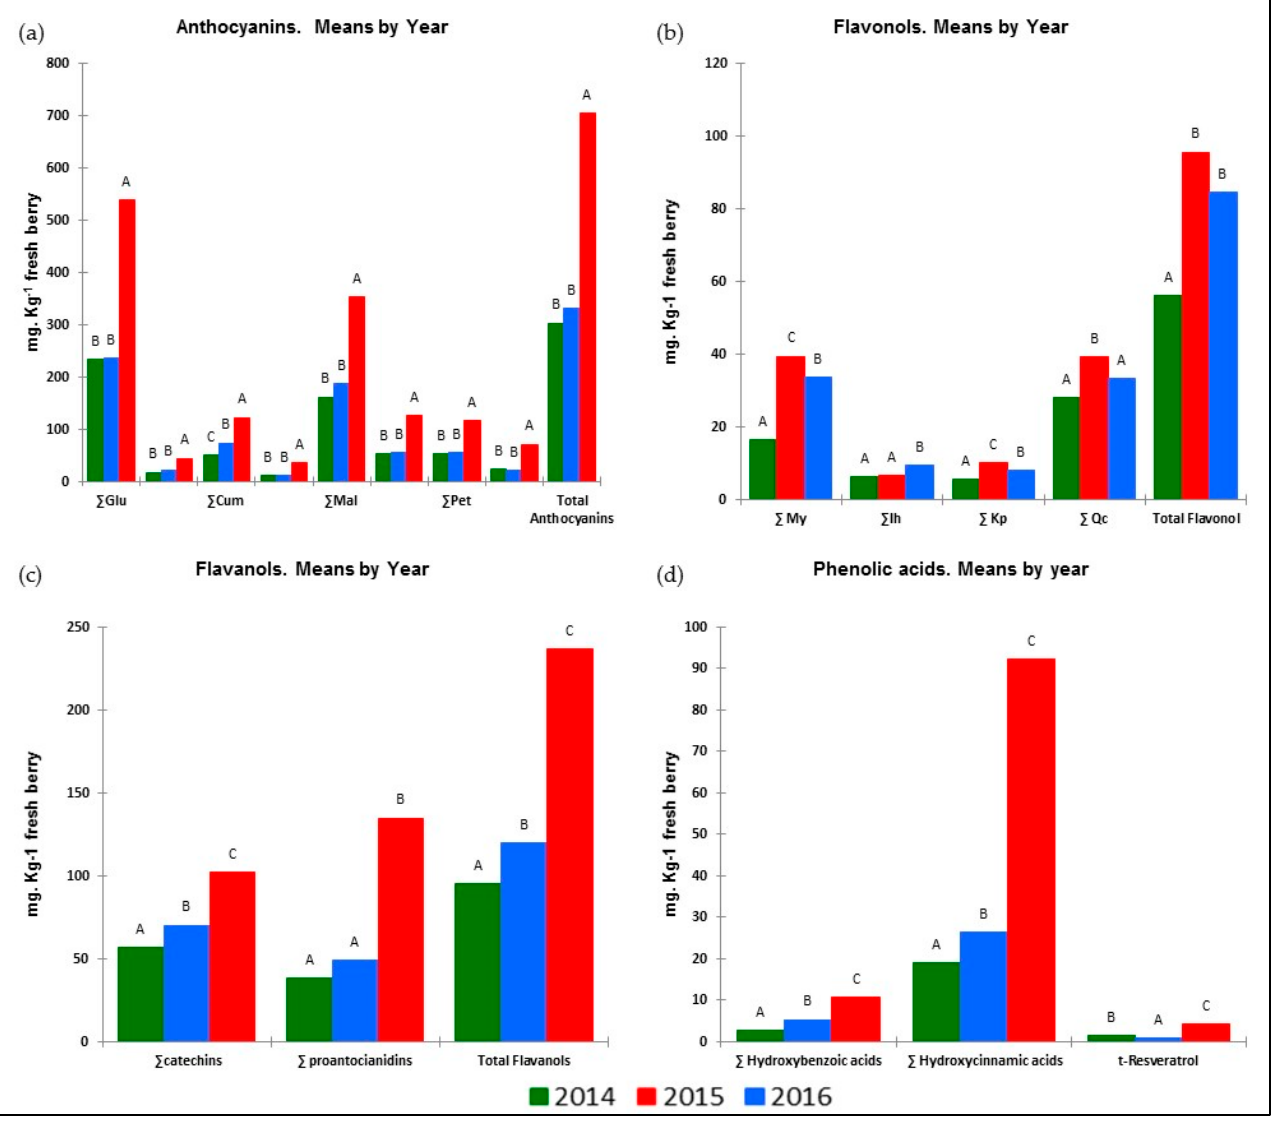
Figure 1. Influence of season on berry phenolic families during the 2014–2016 seasons: ( a ) anthocy- anins; ( b ) flavonols; ( c ) flavanols; ( d ) phenolic acids and resveratrol. (For each parameter, means followed by different capital letters are significantly different between treatments, p < 0.05, Tukey’s HSD test.)